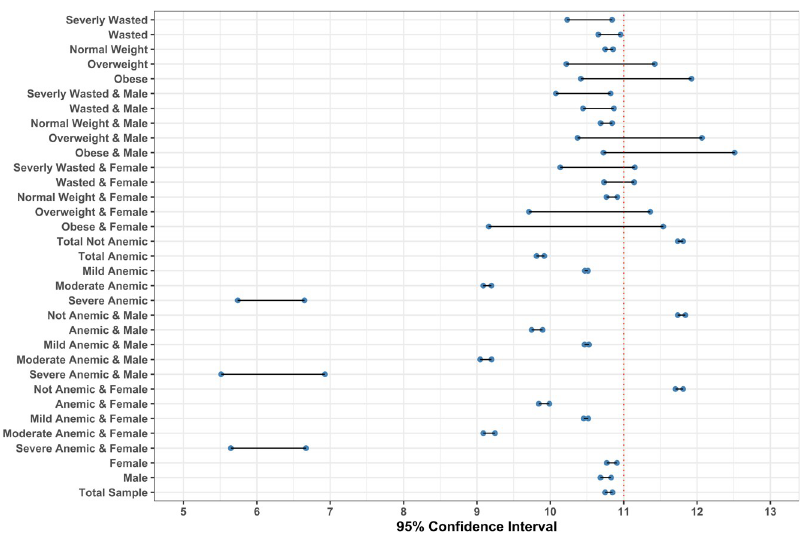
Fig 6. Forest plot of 95% CI of blood hemoglobin level of children (n = 2373). (Vertical lines are Anemia cut-off point [red dotted line at 11 gm/dl]).